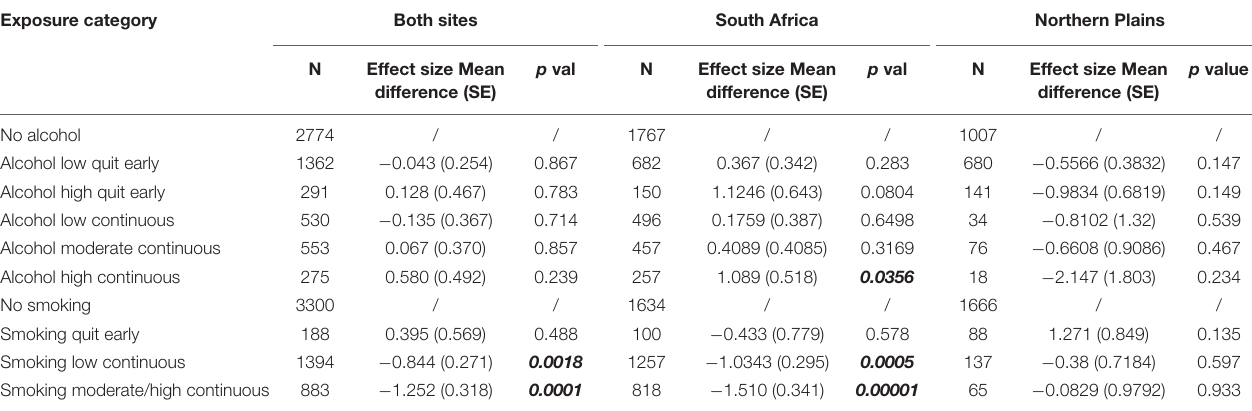
TABLE 6 | Linear regression results from alcohol and smoking exposure predicting Mean HR in